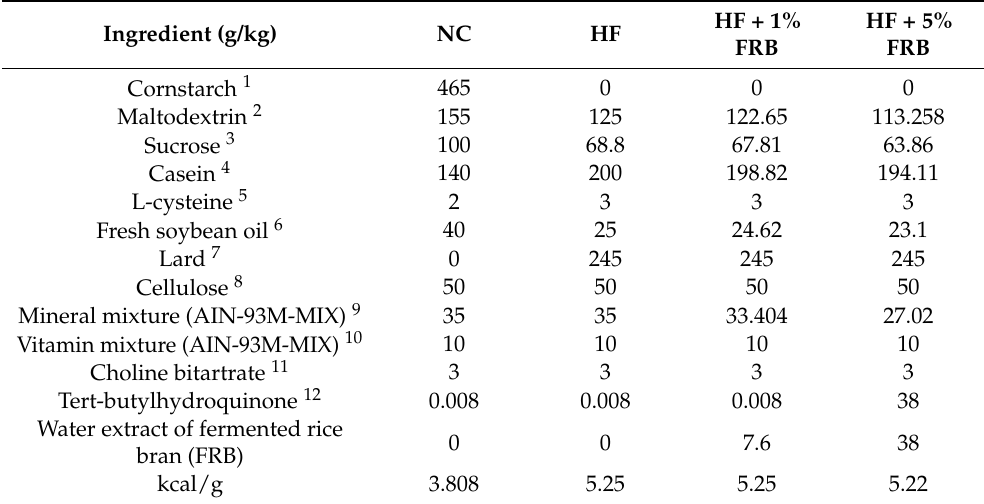
Table 8. Composition of the experimental